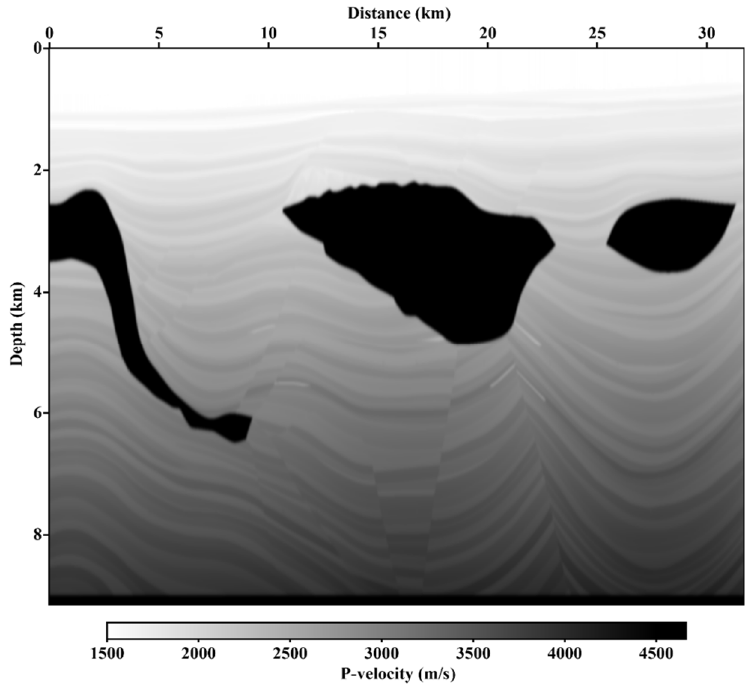
Figure 7. Pluto 1.5 velocity model.